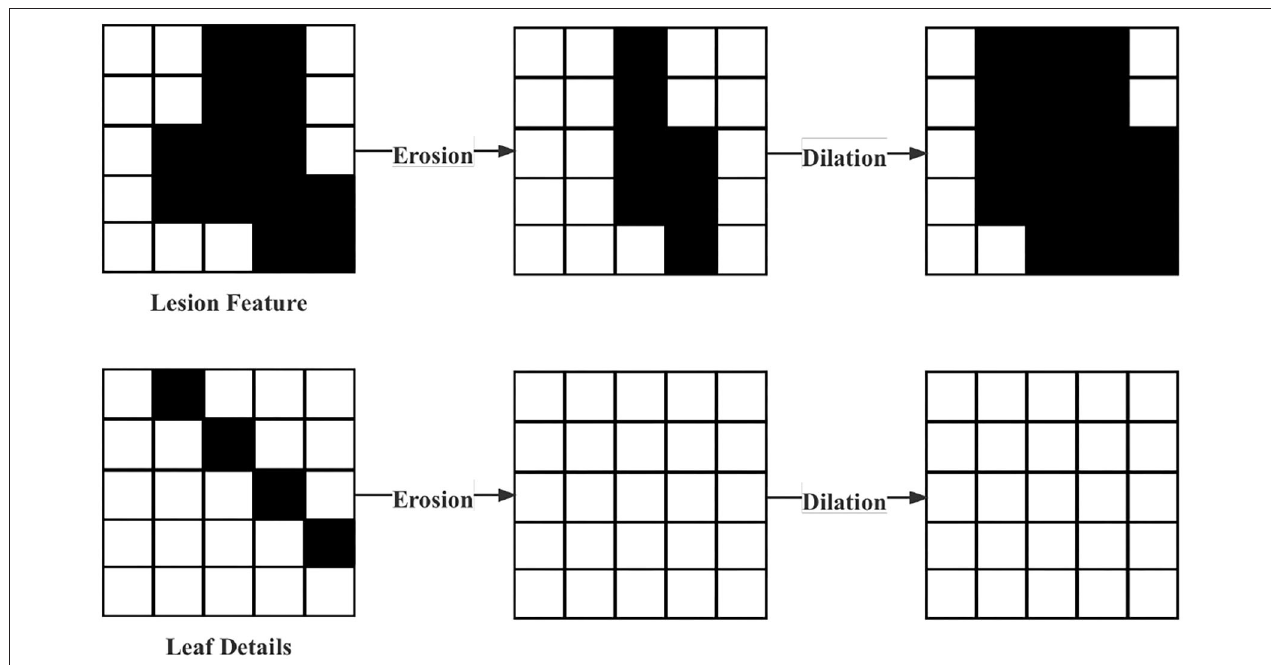
FIGURE 2 | Processing of removal of interferential leaf